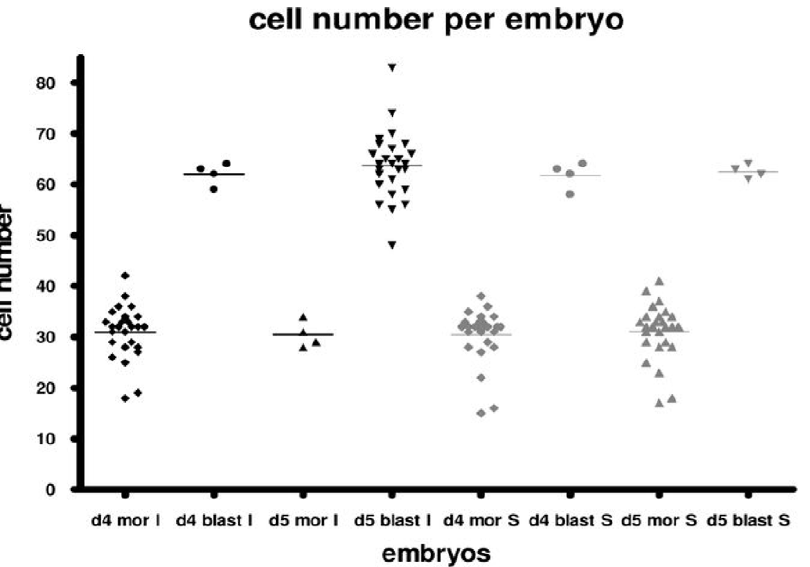
Figure 6. Assessment of cell number per embryo. Cell number per embryo in Sox2- siRNA (grey) and incubator-control morulae and blastocysts (black) at days 4 and 5 of preimplantation development. The Sox2 -siRNA embryos were confirmed to be Sox2 knock-down embryos, as assessed by absence of fluorescence after Sox2 immunostaining. Day 4 Sox2- siRNA morulae (d4 mor S, N=26) were compared with day 4 incubator-control morulae (d4 mor I, N=26) and day 4 Sox2 -siRNA blastocysts (d4 blast S, N=4) were compared with day 4 incubator-control blastocysts (d4 blast I, N=4). Day 5 Sox2 -siRNA morulae (d5 mor S, N=26) were compared with day 5 incubator-control morulae (d5 mor I, N=4) and day 5 Sox2 -siRNA blastocysts (d5 blast S, N=4) were compared with day 5 incubator-control blastocysts (d5 blast I, N=26). Chi-square tests revealed that there was no statistically significant difference between these groups. Thus arrested Sox2 -siRNA morulae remain at the cell number for the morula stage when control embryos have divided further and formed blastocysts. Embryos from all three Sox2 knock-down groups were